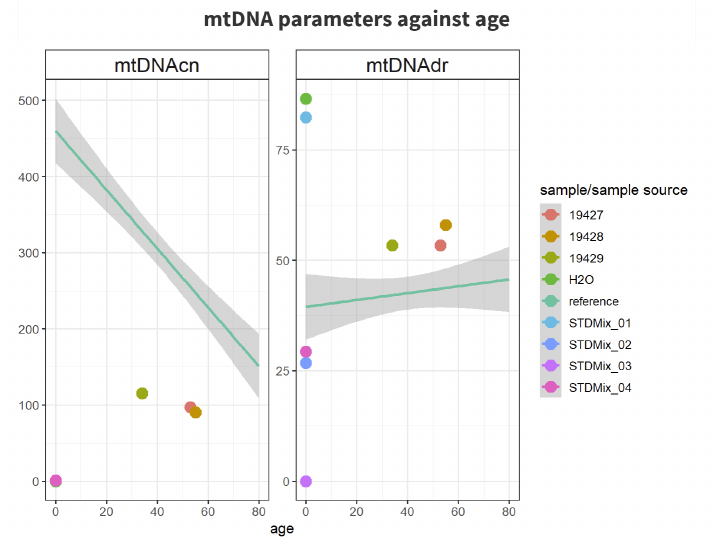
Figure 6. Linear regression plot showing the age-dependency of mtDNA CN and mtDNA DR based on reference data and the currently analyzed